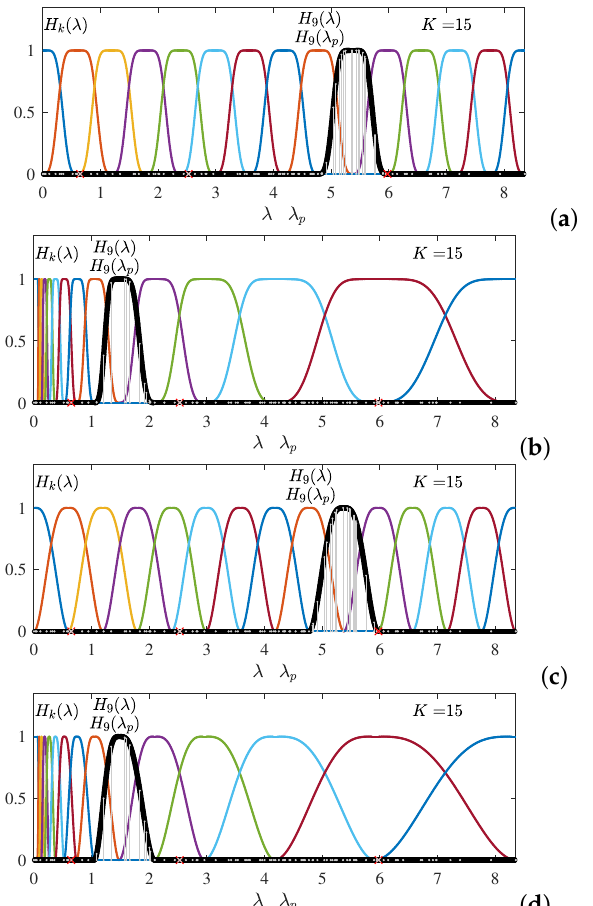
Figure 13. Transfer functions formed using the Hann window ( a , b ) and the Bartlett window square root with modified argument ( c , d ), using the argument x mapping v x ( x ) = x 4 ( 35 − 84 x + 70 x 2 − 20 x 3 ) . The WOLA reconstruction condition ∑ K − 1